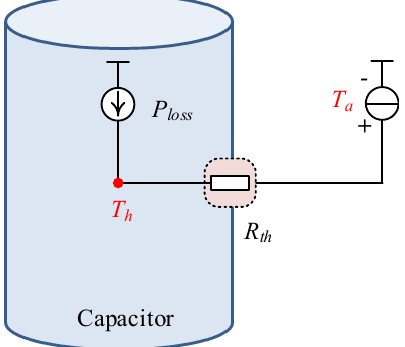
Figure 6. A lumped thermal model of SM capacitors.